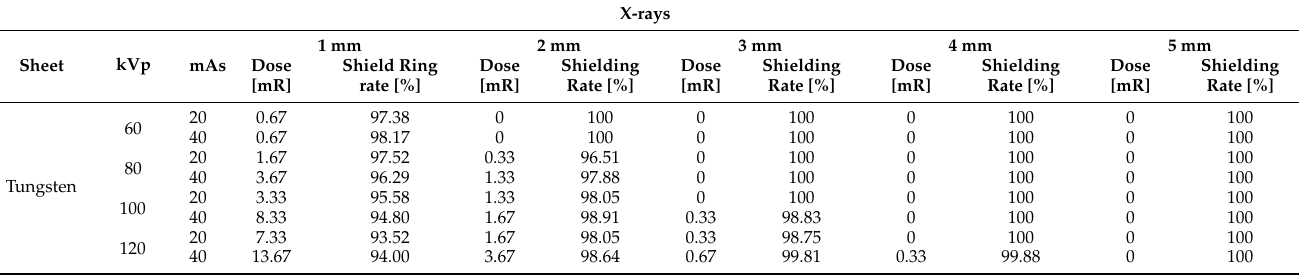
Table 4. Results of the X-ray radiation shielding sheet tests (60, 80, 100, 120 kVp, 20, 40